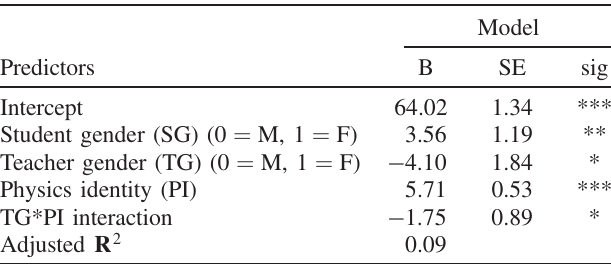
significance of the interaction with student gender and the TABLE III. Regression model predicting student evaluations of physics teachers (100 point scale) incorporating gender and physics identity proxy. Note that ***: p < 0 . 001 , **: p < 0 . 01 , *: p < 0 . 05 .